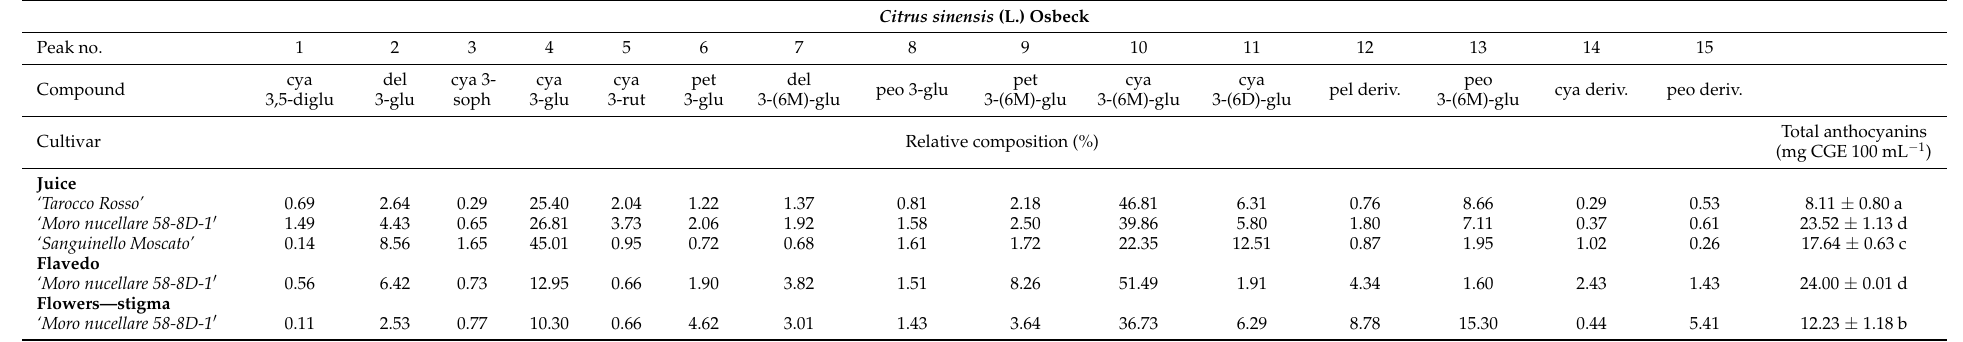
Table 1. Identification and relative amounts of anthocyanins in blood orange juices, peel, and flower stigma. Reprinted from Fabroni et al. [2]. Citrus sinensis (L.)